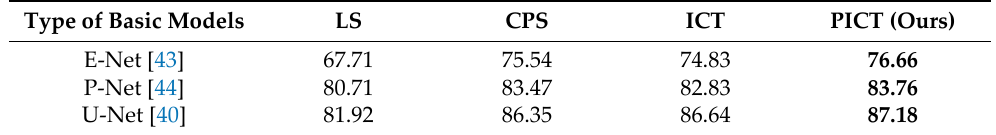
Table 3. The DSC score (%) comparison of CPS, ICT, and PICT on ACDC dataset under different basic models with using 7 labeled cases. The bold fonts indicate the best results of the comparing variants.